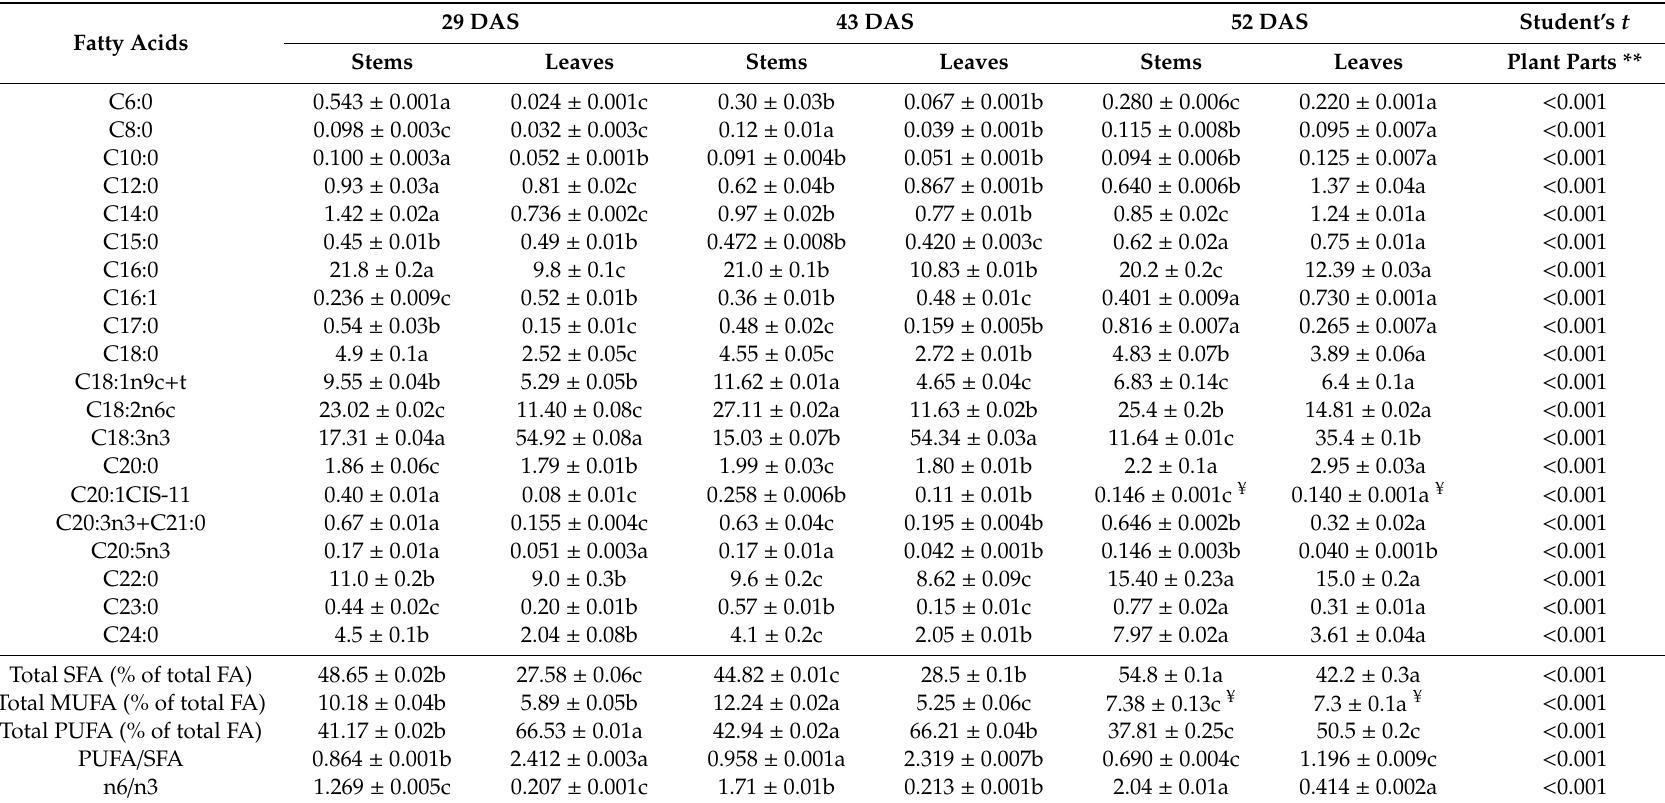
Table 4. Fatty acid composition (%) of the studied purslane stems and leaves (mean ± SD) in relation to harvesting